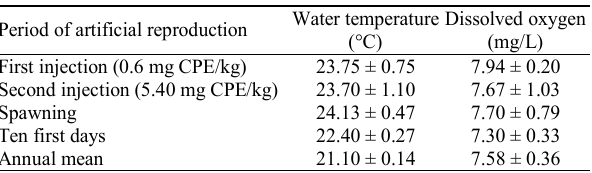
Table 2. Water quality during the period of artificial reproduction at CESP Fish Farm. Data are presented as the mean ± standard